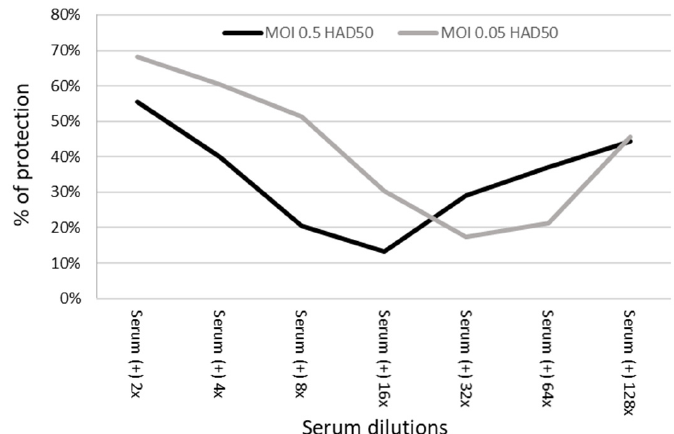
Figure 5. The neutralization expressed as the percentages of protection of 2-fold serially diluted positive sera compared to 2-fold diluted negative sera [protection % = (PI − − PI + )/PI − , where PI − is the percentage of infected cells treated with negative serum and PI + is the percentage of infected cells treated with serum ( − )] in gated monocytes and macrophages infected with different MOI.